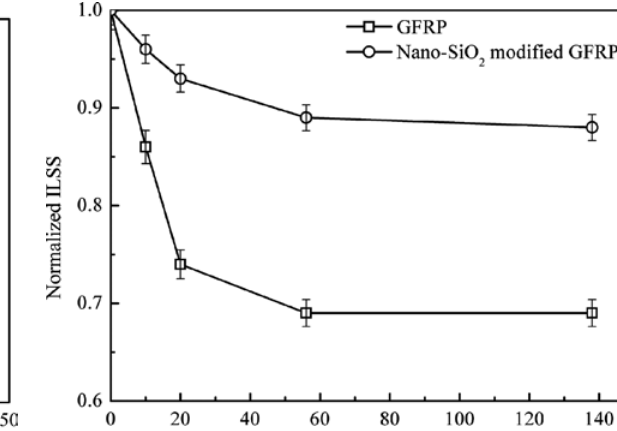
Figure 7: Volume swelling as a function of the immersion time for the GFRP composites.